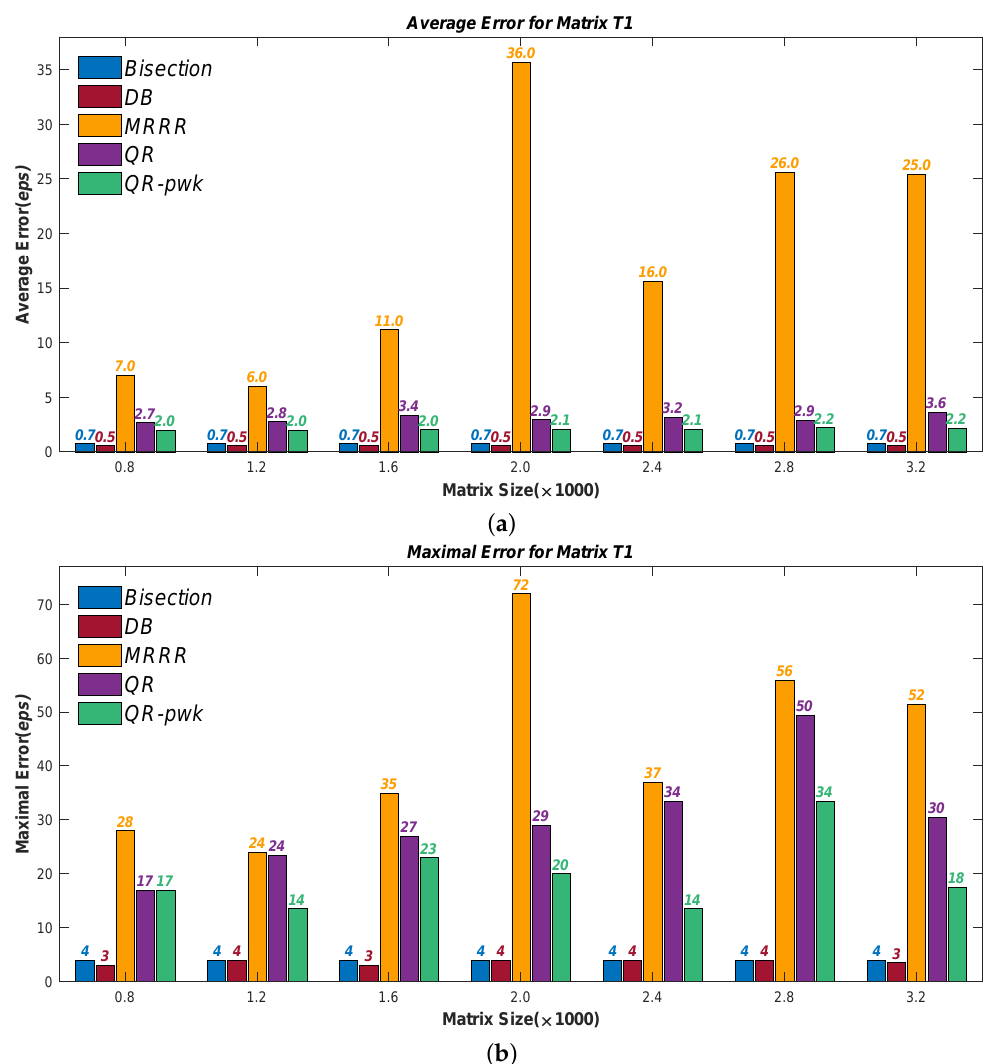
Figure 2. Results of Matrix T1: ( a ) the Average Errors; ( b ) the Maximal